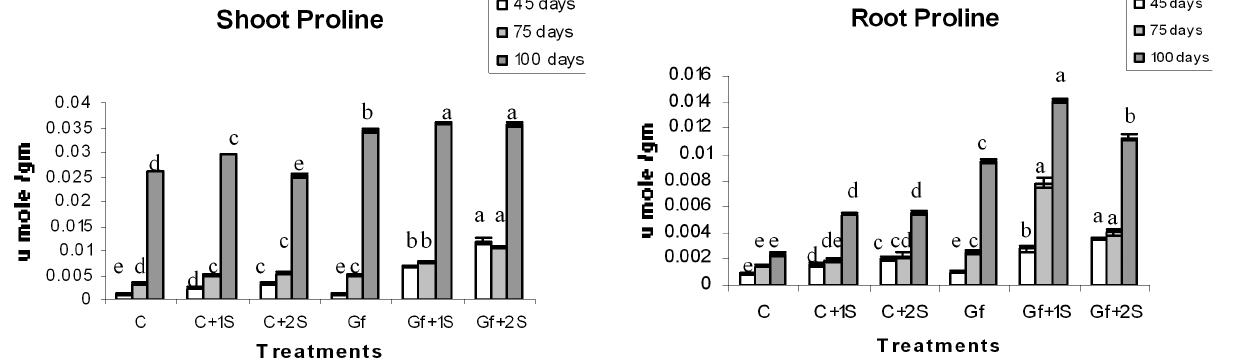
Fig. 5. Root proline content in Gmelina arborea Roxb inocu- lated with Glomus fasciculatum after 45, 75 and 100 days after AM